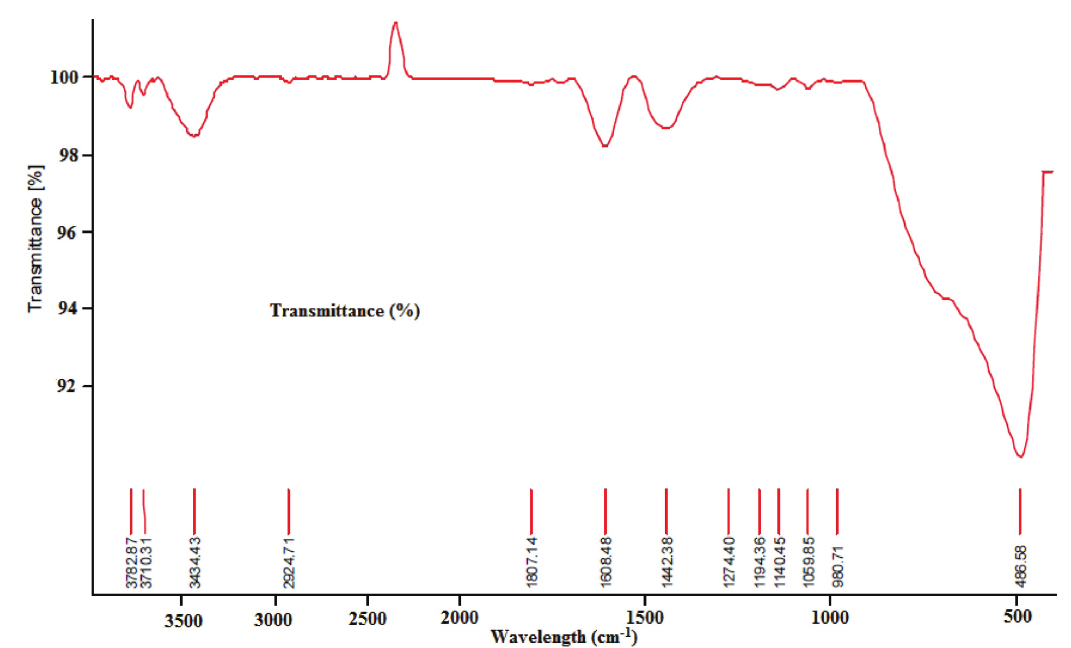
Fig. 2 – FT-IR spectrum of Mn, Mo, la/Tio